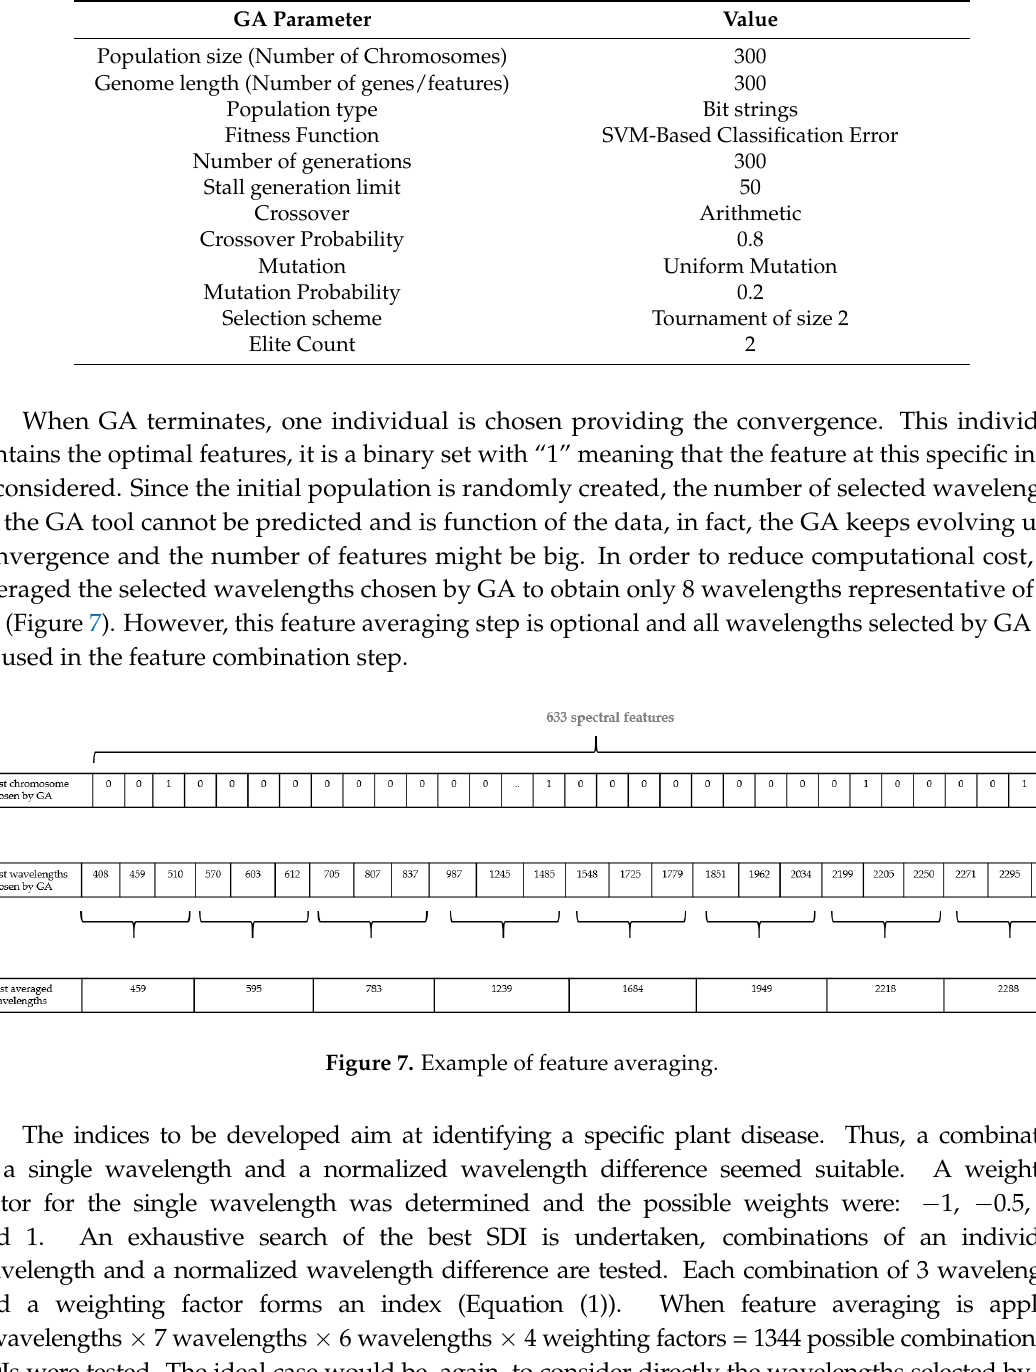
Table 1. Numerical values of different GA parameters considered in this study.